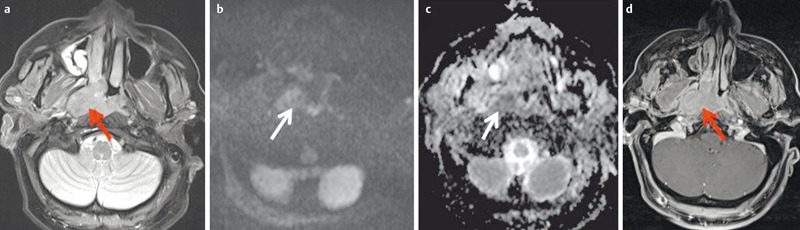
MRI of a 66-year-old patient with a nasal cavity carcinoma extending into the nasopharynx.a) There is marked enhancement on contrast-enhanced T1w image with fat saturation.b) Axial T2w images demonstrate a homogeneous, discretely hypointense tumor (arrow).c) The tumor is hypointense on the ADC-map and the calculated ADC-value is 0.51×10–3 mm2/s. Histologically confirmed squamous cell carcinoma.